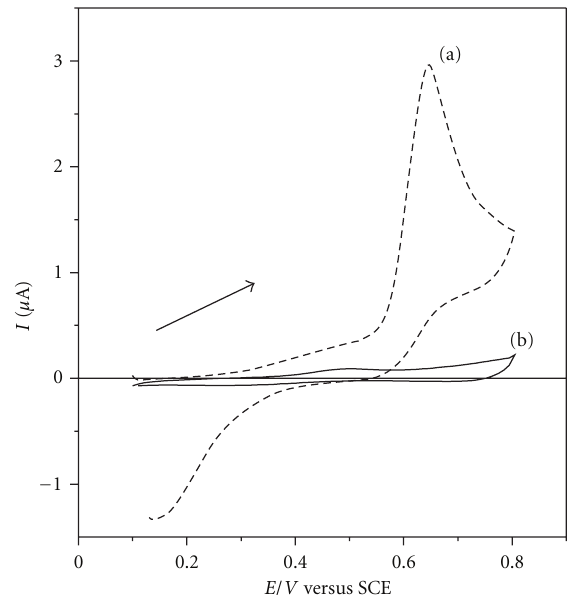
Figure 6: Study of the interaction between dopamine and film active sites: comparison between the electrochemical profile of ITO/(DS 01/NiTsPc) 3 film in (a) presence of DA (1.9608 × 10 − 5 mol L − 1 ) and in (b) DA absence, electrolyte solution H 2 SO 4 0.05mol L − 1 , at 25 mVs − 1 .